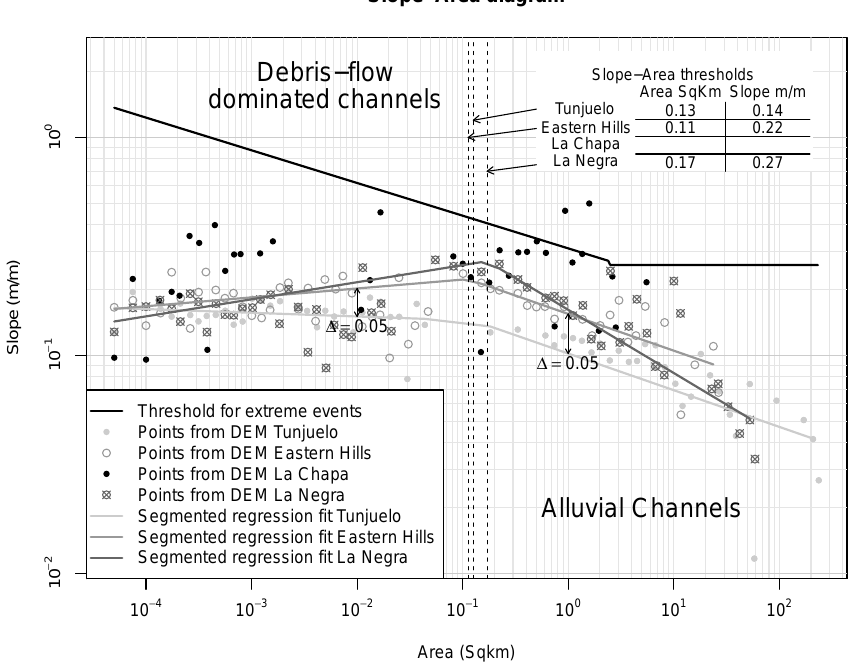
Figure 4. Slope–area diagram for the study area and comparative areas. This figure shows the log slope versus log area for each pixel in the watershed areas. To increase readability the value of the slope is averaged in bins of 0.2 log of the drainage area. The black line corresponds to the curve of extreme events given by Eqs. (1) and